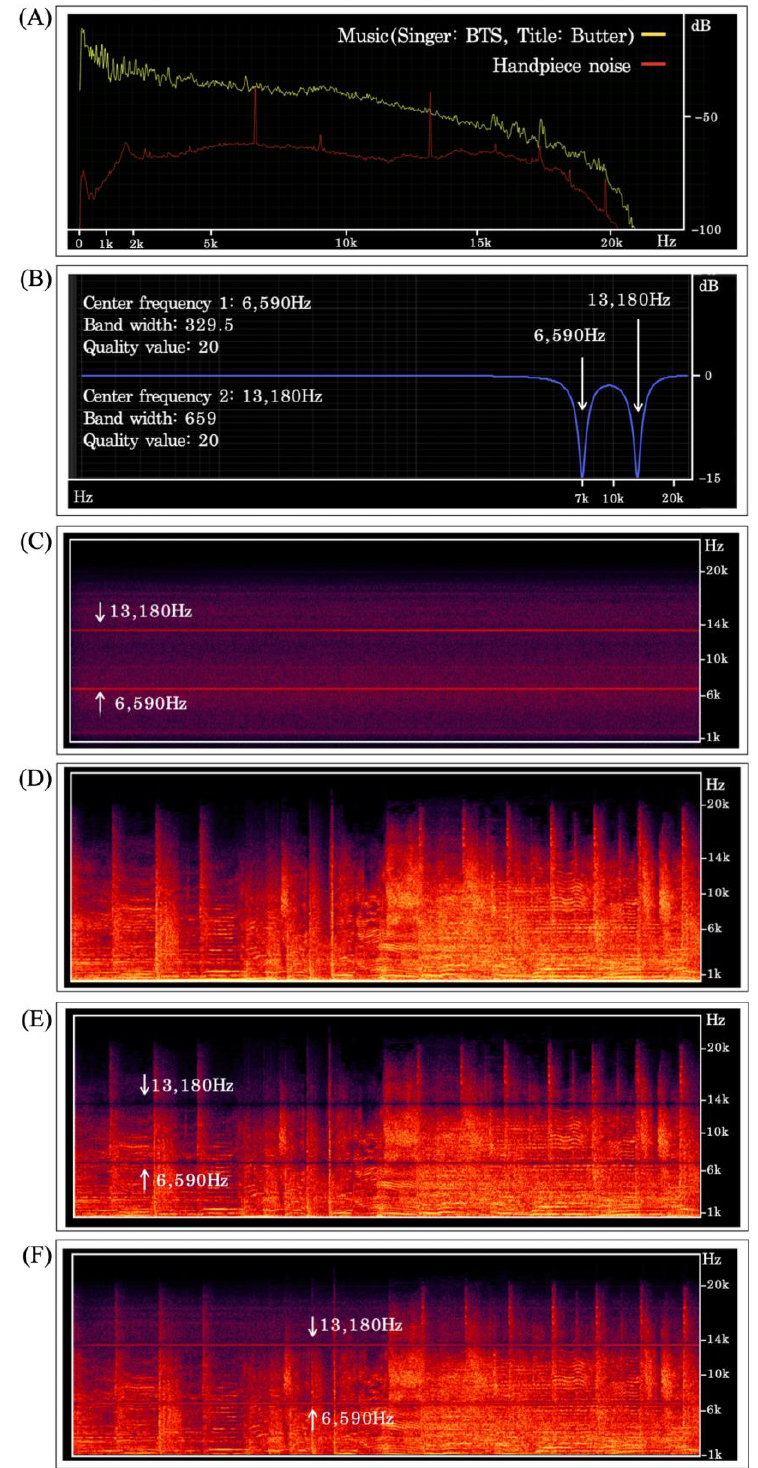
Figure 3. ( A ) Spectrogram analysis result of music and handpiece noise using FFT; ( B ) notch filter design; ( C ) high-speed mode dental handpiece noise; ( D ) music (singer: BTS, title: “Butter”); ( E ) music from which the target frequency of dental handpiece noise has been removed with notch filter; ( F ) synthesis of ( C , E